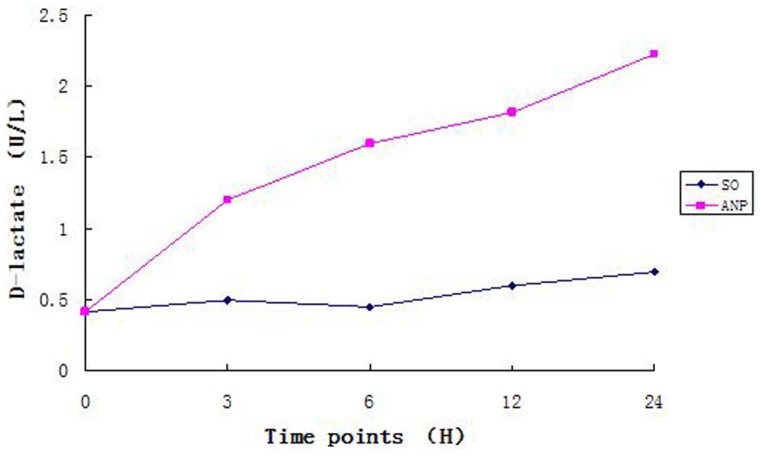
Induction of D-Lactate. Described the variation tendency of D-Lactate in two groups.